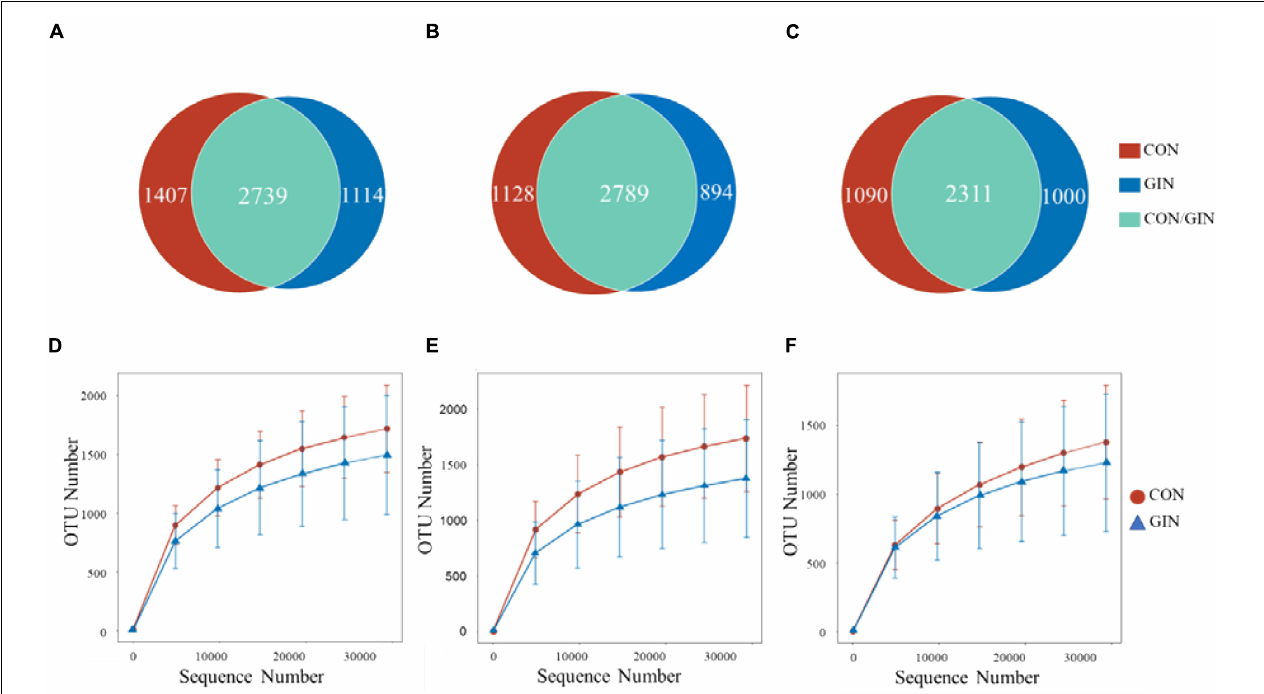
FIGURE 3 | Venn diagrams of rumen, abomasum and duodenum is (A–C) , respectively and rarefaction curves of rumen, abomasum and duodenum is (D–F) of lambs infected with Haemonchus contortus .